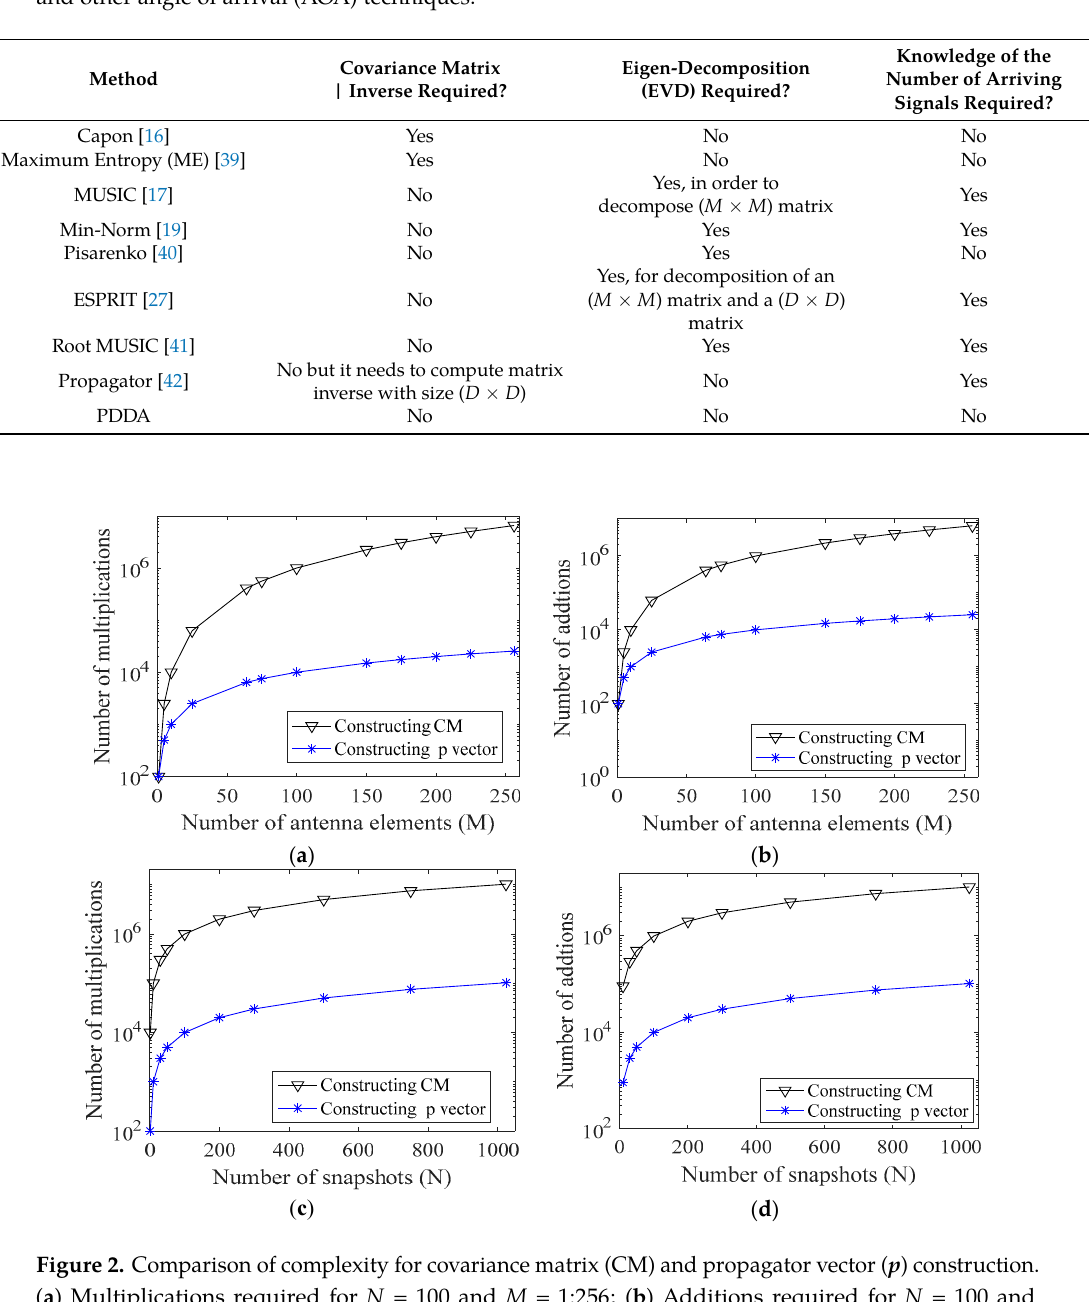
PDDA and popular AOA methods.